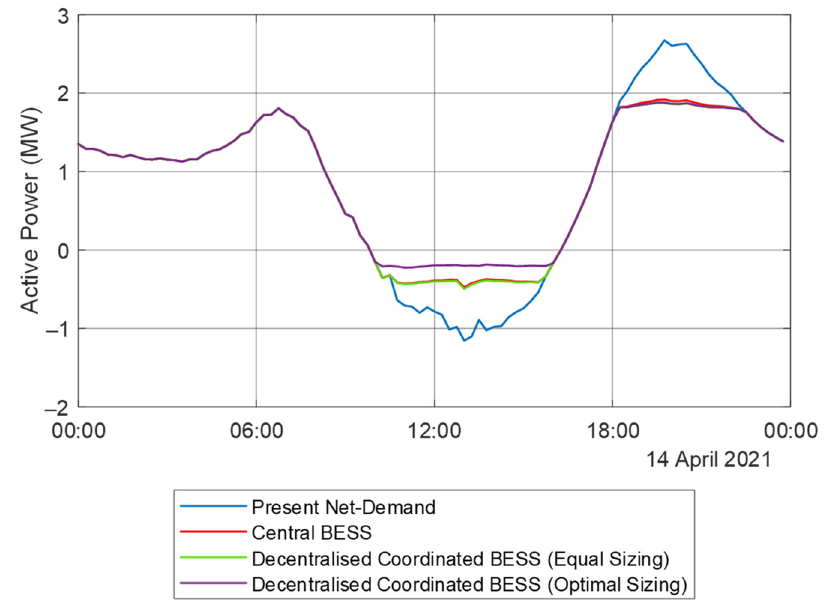
Figure 9. Net-demand profile at Xewkija DC with and without storage sized as determined by the BUF defined in Section 2.3.